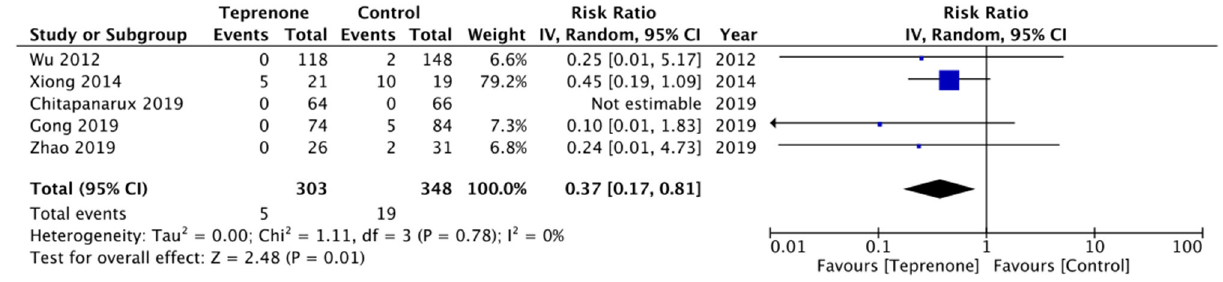
FIGURE 2 | Forest plot for incidence of GI ulcers between teprenone vs. control.